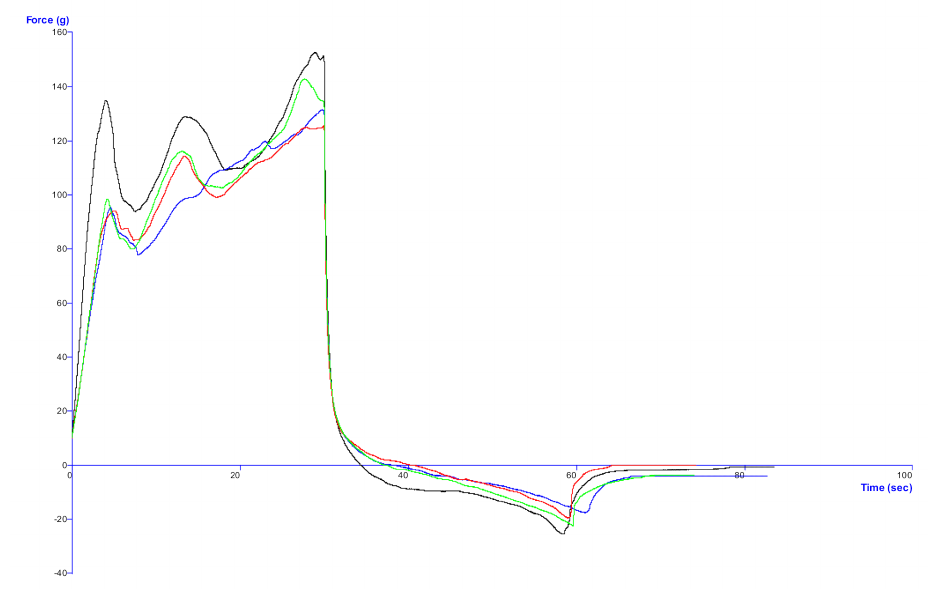
Figure 1. Analysis of the texture profile of kefir samples on the first day of storage.